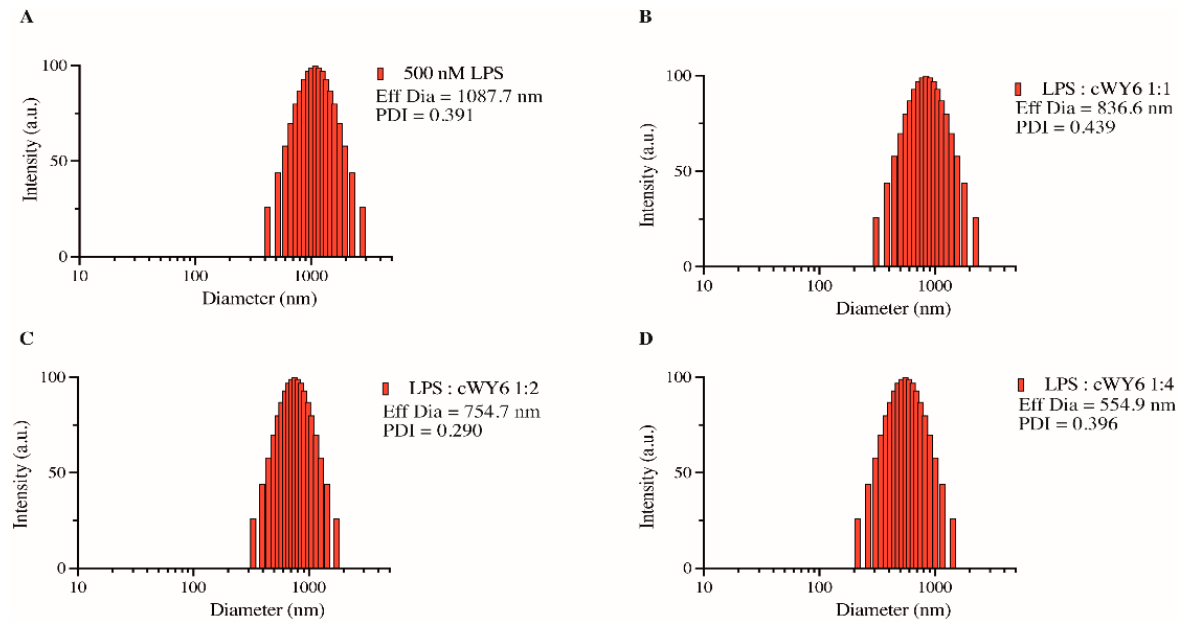
Figure 5. Bar diagram, obtained from dynamic light scattering experiments, showing effective diameter of LPS micelle alone ( A ) and at various ratios of LPS/cWY6 peptide ( B – D ). 2.6. Red Blood Cell (RBC) Lysis and Mammalian Cell Toxicity of cWY6 Peptide The potential cytotoxicity of the designed cyclic cWY6 peptide was evaluated by hemolysis and MTT assays. Figure 6A shows % hemolysis of human RBC at different